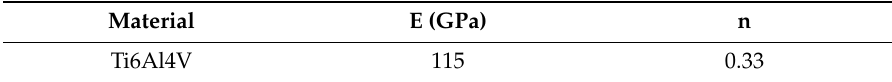
Table 2. Main mechanical properties of the titanium alloy Ti6Al4V.